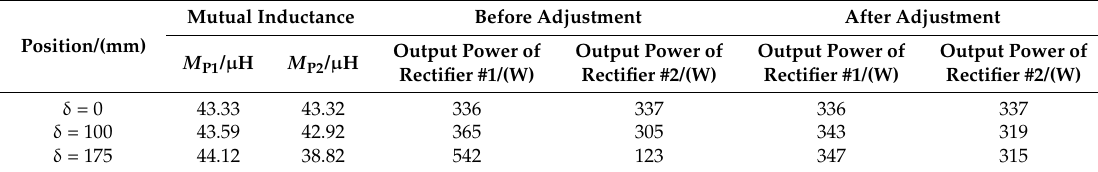
Figure 15. Input voltage and current waveforms of the receivers when the load is 10 Ω and δ equals 175 mm. Table 2. The output power of receivers before and after the current control applied.